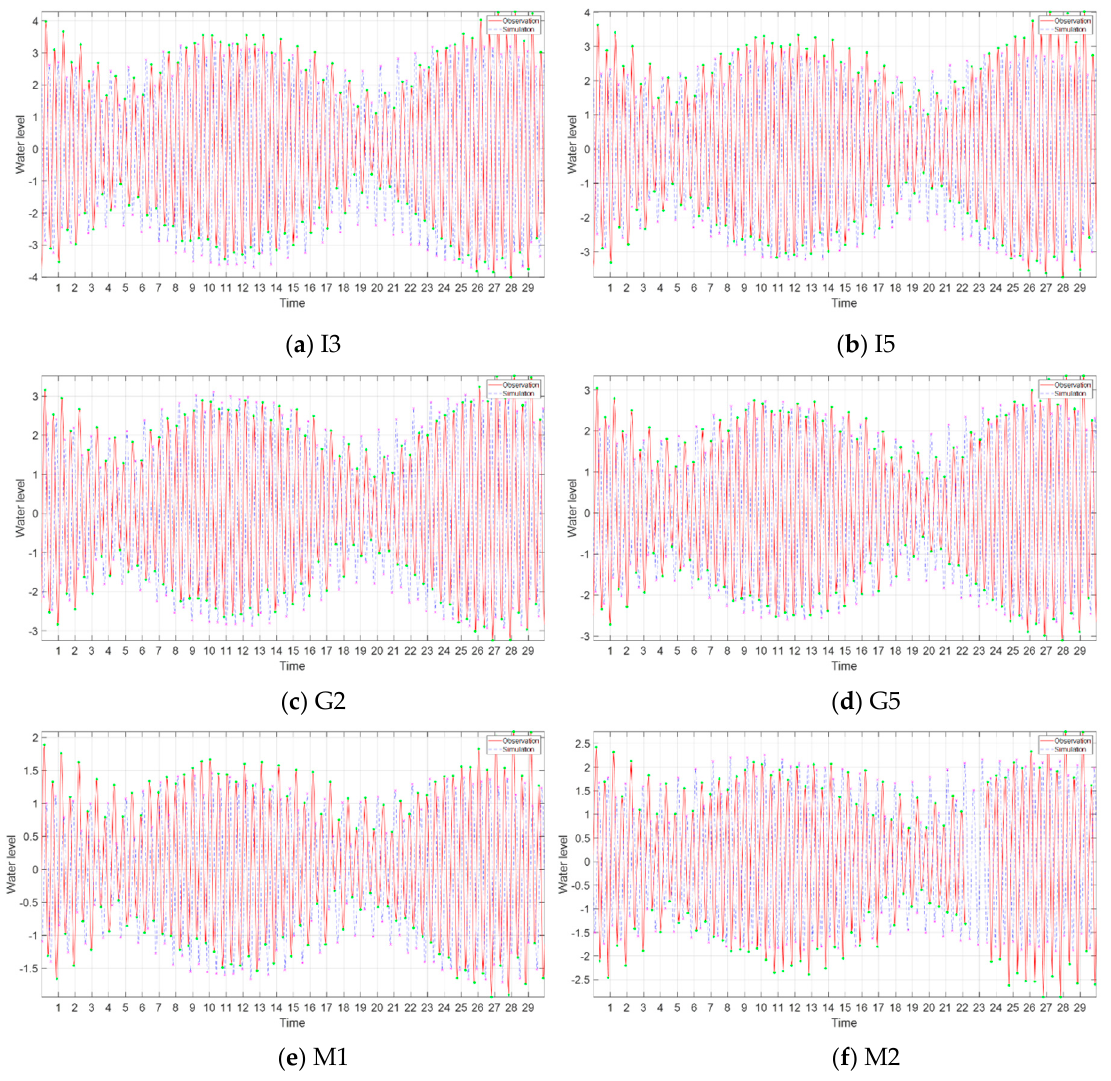
Figure 14. A comparison of water level between numerical results and observations at typical gauge stations; ( a ) and ( b ): water level at gauge station I3 and I5 (located in Incheon Region); ( c ) and ( d ): water level at gauge station G3 and G5 (located in Gunsan Region); ( e ) and ( f ): water level at gauge station M1 and M2 (located in Mokpo Region).